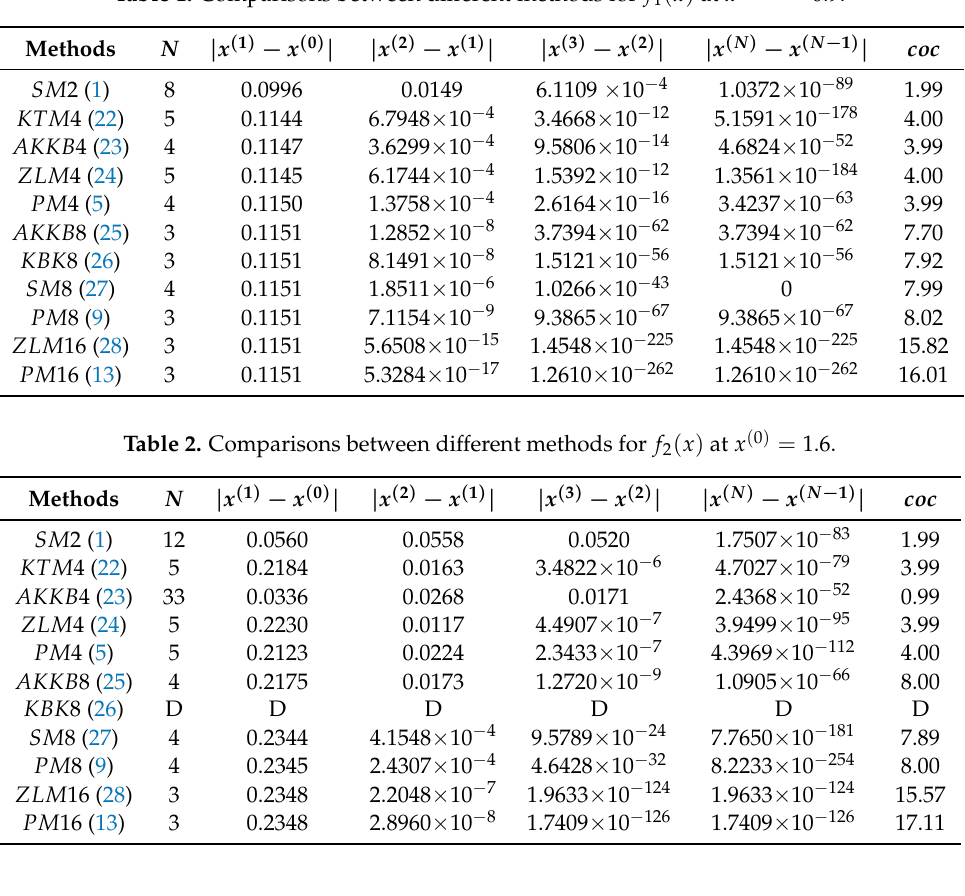
Table 1. Comparisons between different methods for f 1 ( x ) at x ( 0 ) = − 0.9.